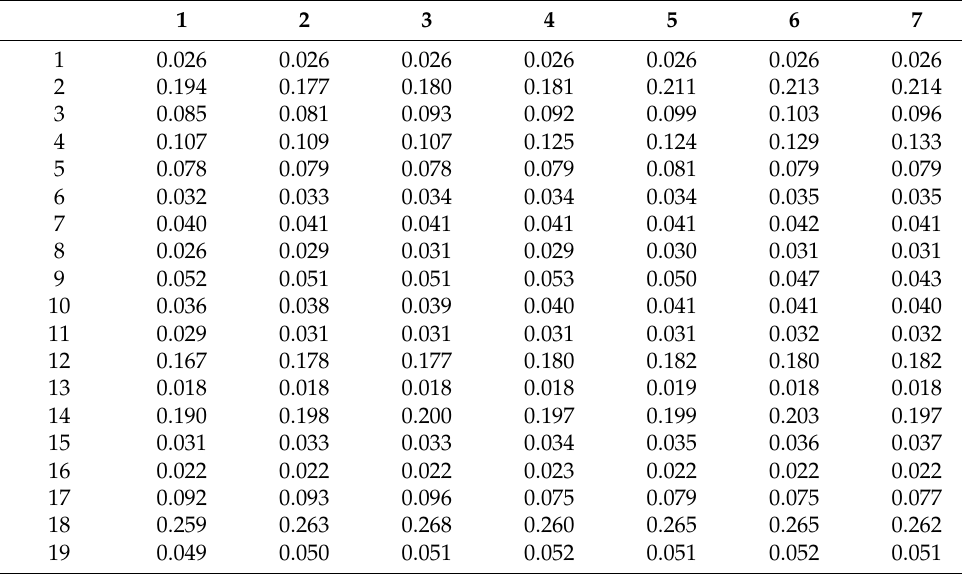
Table A1. Short-term prediction error (RMSE) of the temperature-based model—application to 19 tanks, 7-day prediction horizon.